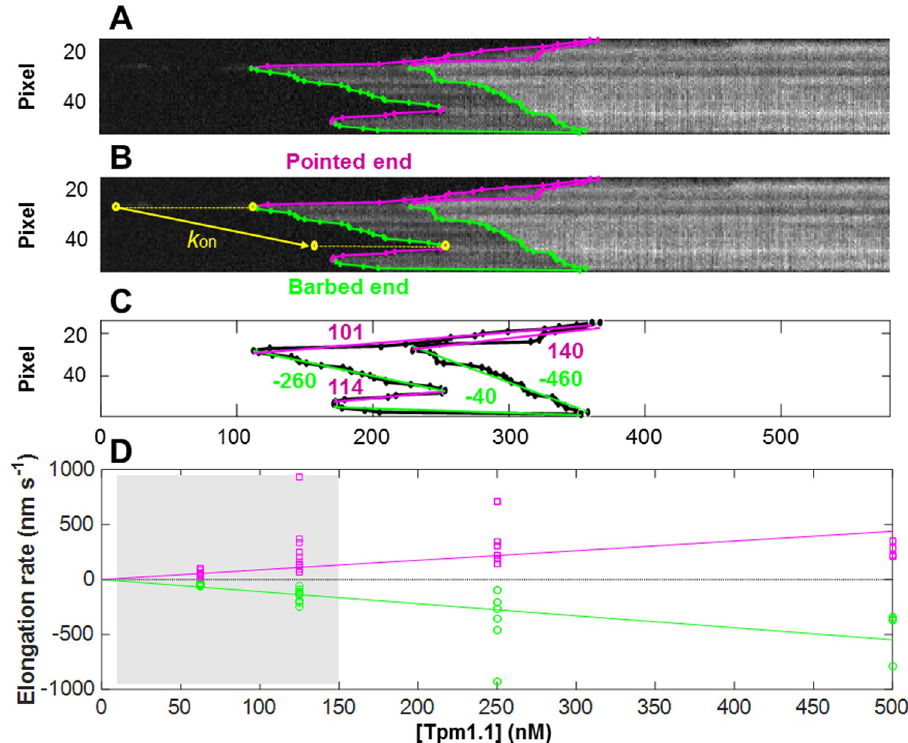
Fig 7. Estimation of elongation rates from edges of kymograph. (A) Kymograph of the AF647-Tpm1.1 nucleation and elongation on single actin filament. Two levels of intensities represent separate Tpm binding on two sides of the filament. (B) Edges of the kymograph were detected as described in the text. Green and magenta edges show individual Tpm1.1 elongation stretches towards barbed and pointed end of the filament, respectively. The yellow arrow demonstrates the average Tpm1.1 elongation rate extracted by linear fits to the kymograph boundary data. (C) Individual rates for each Tpm1.1 elongation segment on both grooves of actin filament. The weighted average elongation rate towards the barbed end was 136 nm s -1 and towards to pointed end 104 nm s -1 for the filament edges in Fig 3B. (D) Tpm1.1 elongation on actin towards opposite ends of the filament as a function of the feed concentration for all filaments (S1 Dataset). The lines show linear least squares fits constrained to go through the origin. These indicate that the elongation increases with the feed concentration at 1.1 nm s -1 nM -1 towards the pointed end and at 0.88 nm s -1 nM -1 towards the barbed end. The shaded area between 0 and 150 nM represents data points with slower protein delivery into the channel, which may have altered the actual concentration at which the association took